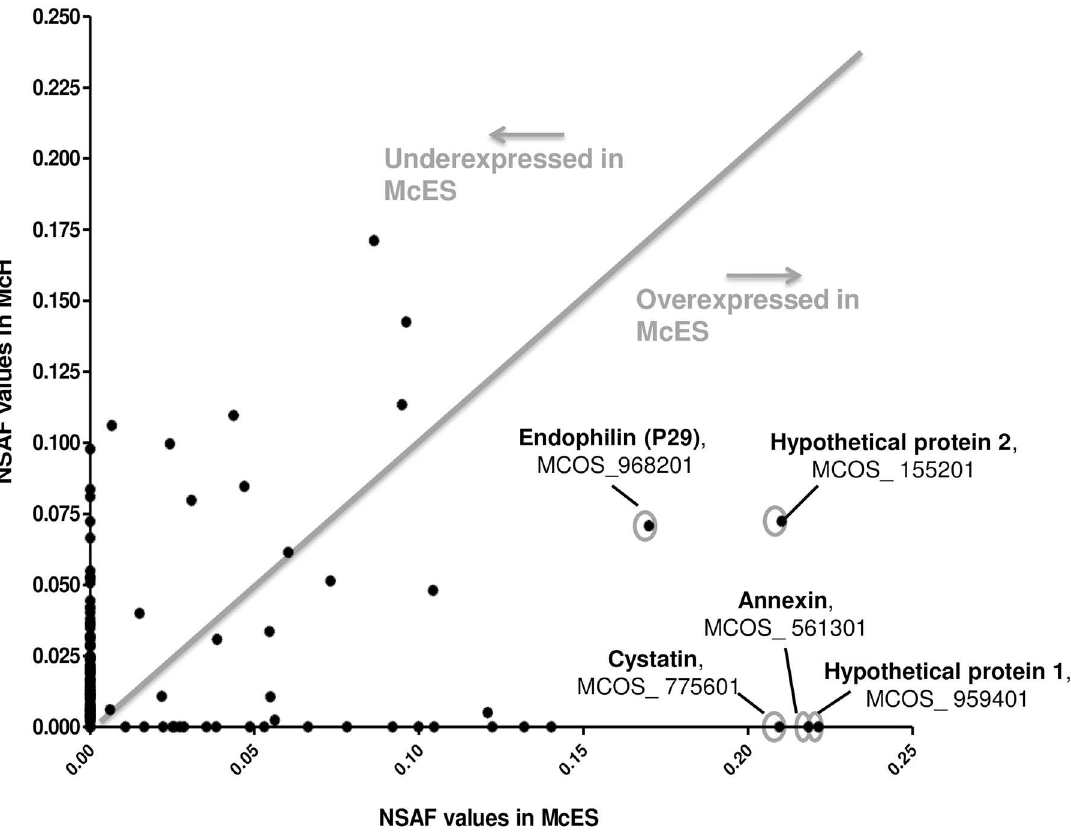
Fig 7. Relative abundance of proteins in McH and McES. Bivariant plot of NSAF values of proteins from McH and McES. Proteins over-represented in McES are highlighted.